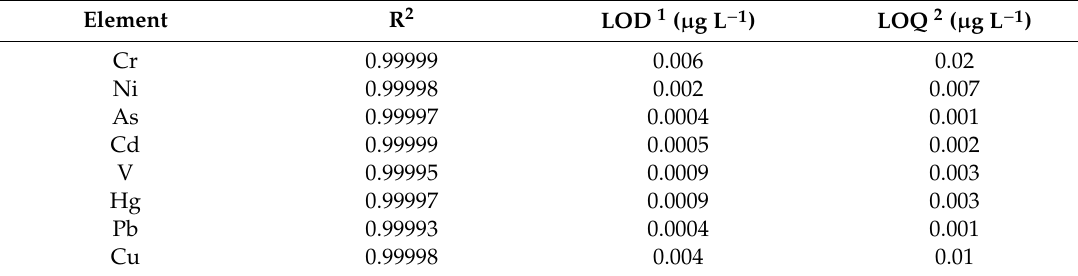
Table 2. Analytical performance of the